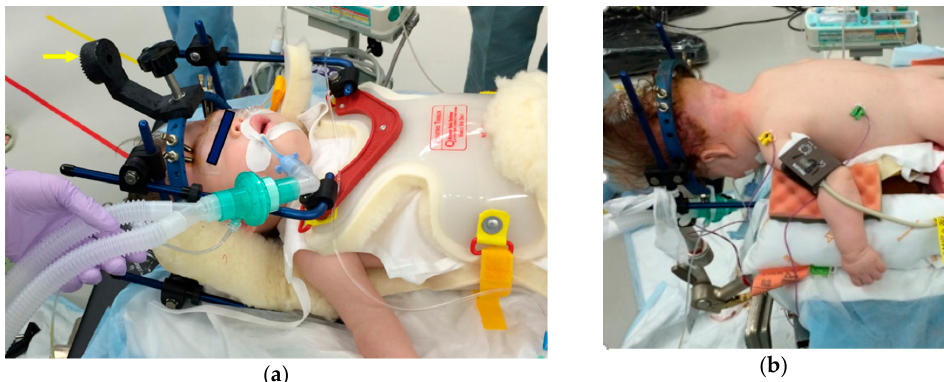
Figure 7. Patient positioning for an infant with MPS using a halo-vest. The halo-vest was placed under